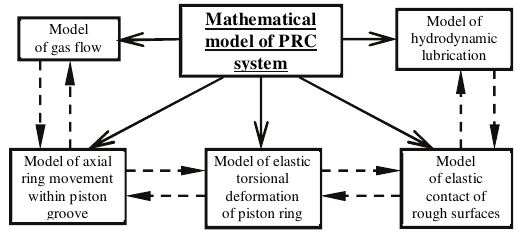
Fig. 1. Developed comprehensive model of the system: piston-ring- cylinder (PRC)